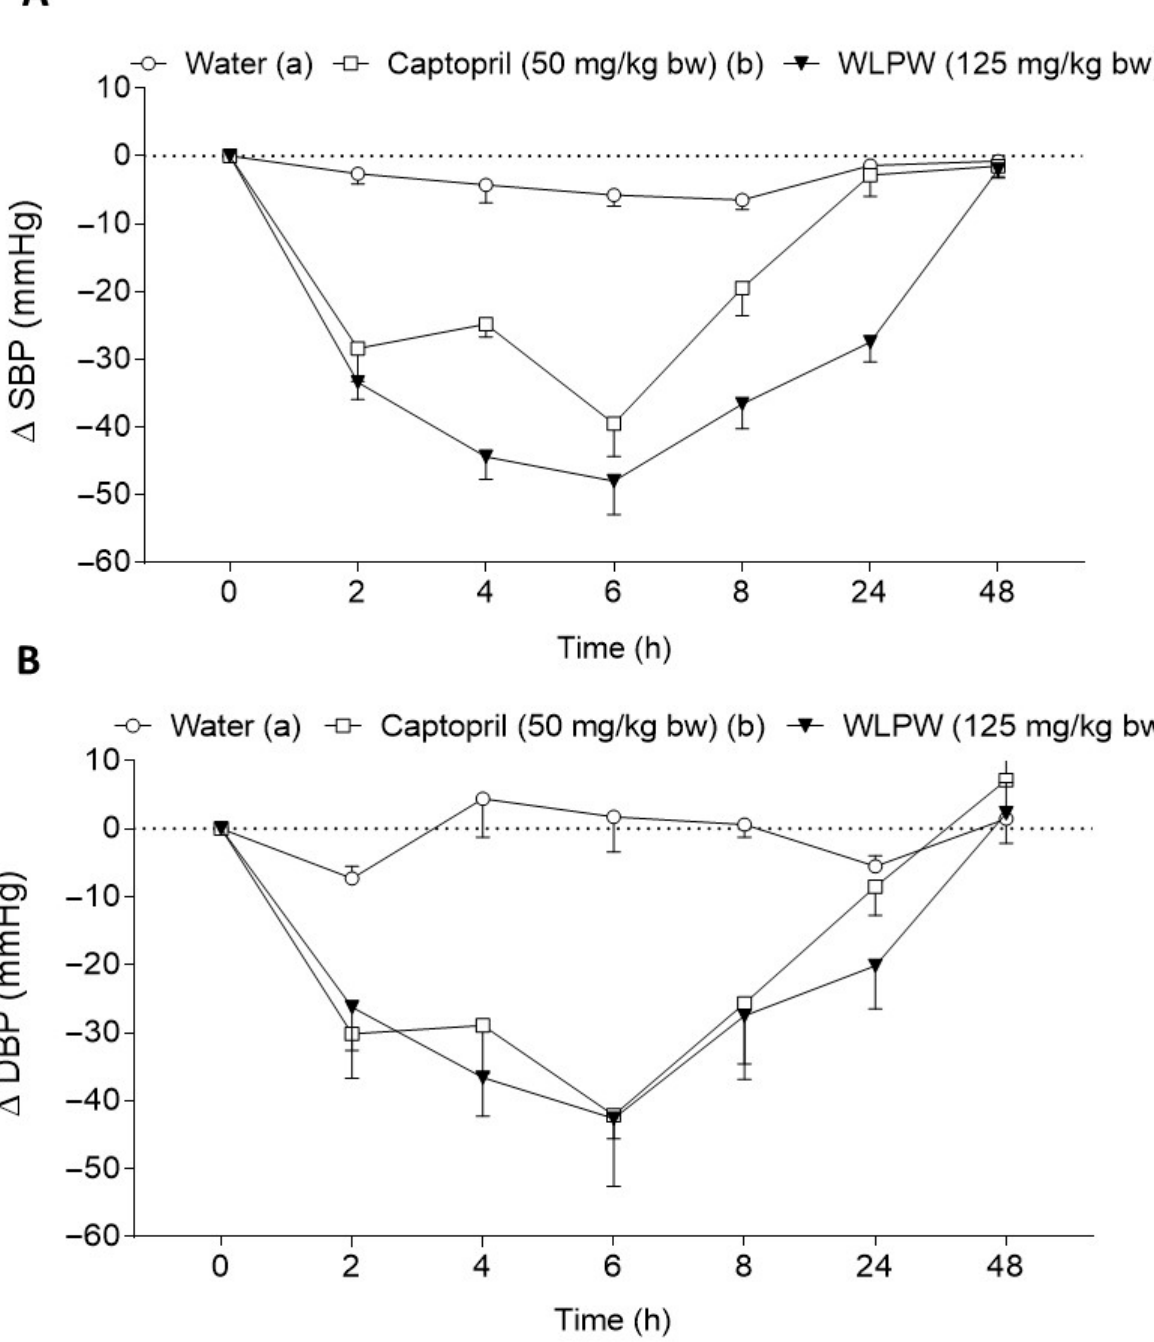
Figure 3. ( A ) Changes in systolic blood pressure (SBP) and ( B ) diastolic blood pressure (DBP) caused in spontaneously hypertensive rats by the acute administration of water, Captopril (50 mg/kg bw) or dried wine lees powder (WLPW) (125 mg/kg bw). Data are expressed as mean ( n = 6) ± SEM. Significant differences ( p < 0.05) are represented by different letters and p was estimated by two-way ANOVA. Tukey test was used as post hoc.